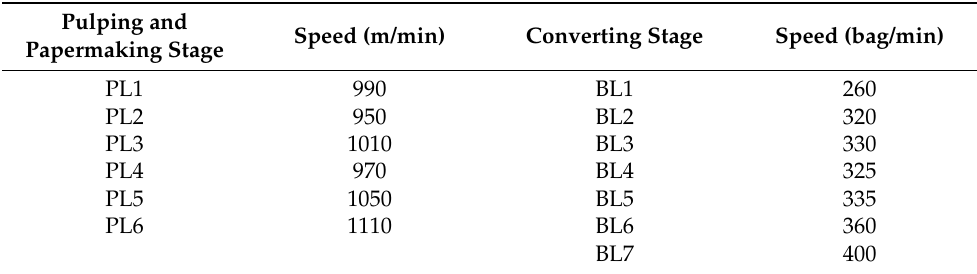
Table 3. The maximum speed of the production line in the pulping and papermaking stage and the converting stage.